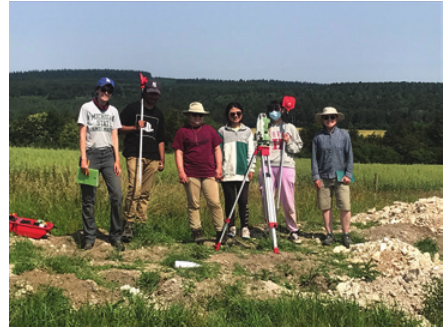
Figure 3 Student field course in 2021 (Source: photograph by Mark